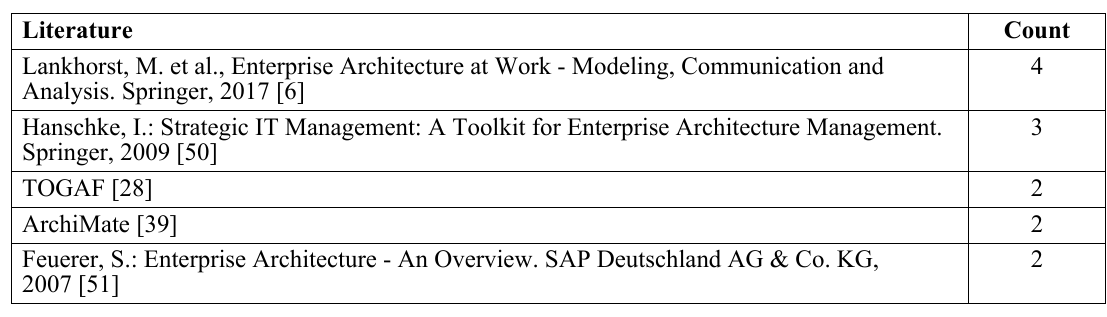
Table 10: 13 courses considered for Business Informatics (BI) and seven for Computer